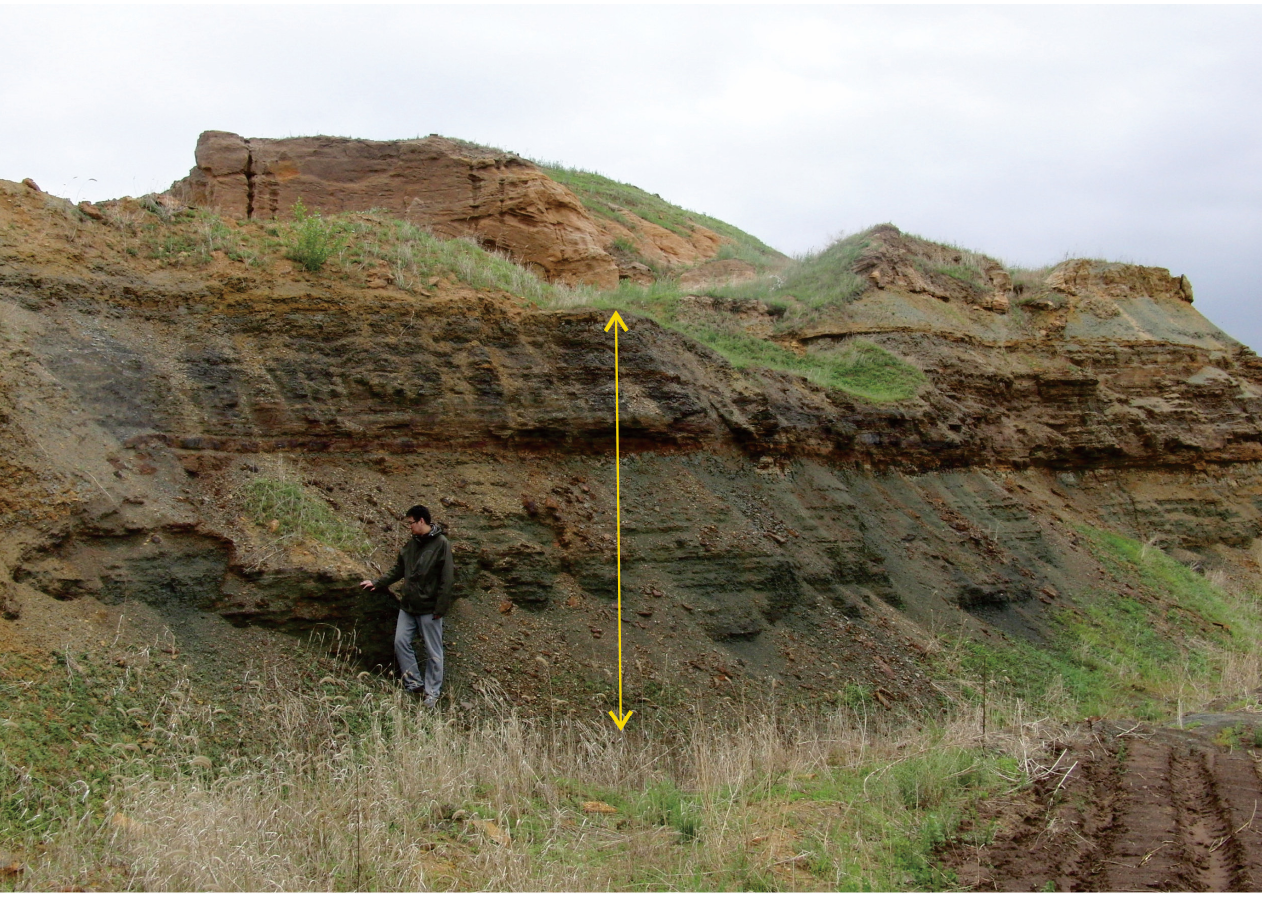
Figure 9. Sedimentary characteristics of the K 2 qn in the outcrop underlying the Yaojia Formation, showing the dark shales formed in a deep or subdeep lake. An overall look of the outcrop marked by the yellow arrows. The deposits are covered by quaternary fluvial sediments showing characteristics of dunes.